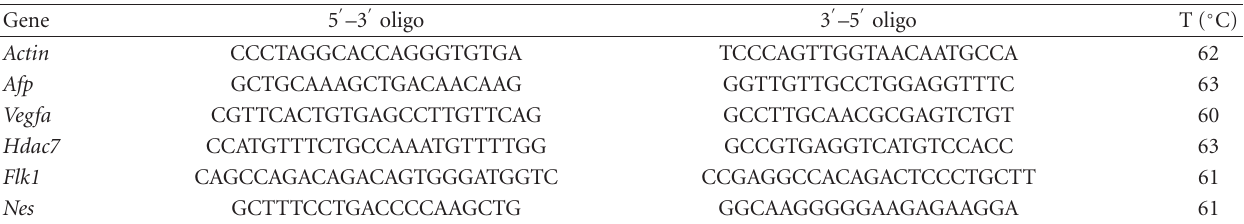
Table 1: Primer sequences and annealing temperatures used in the quantitative RT-PCR experiments. Gene 5 (cid:3) –3 (cid:3) oligo 3 (cid:3) –5 (cid:3) oligo